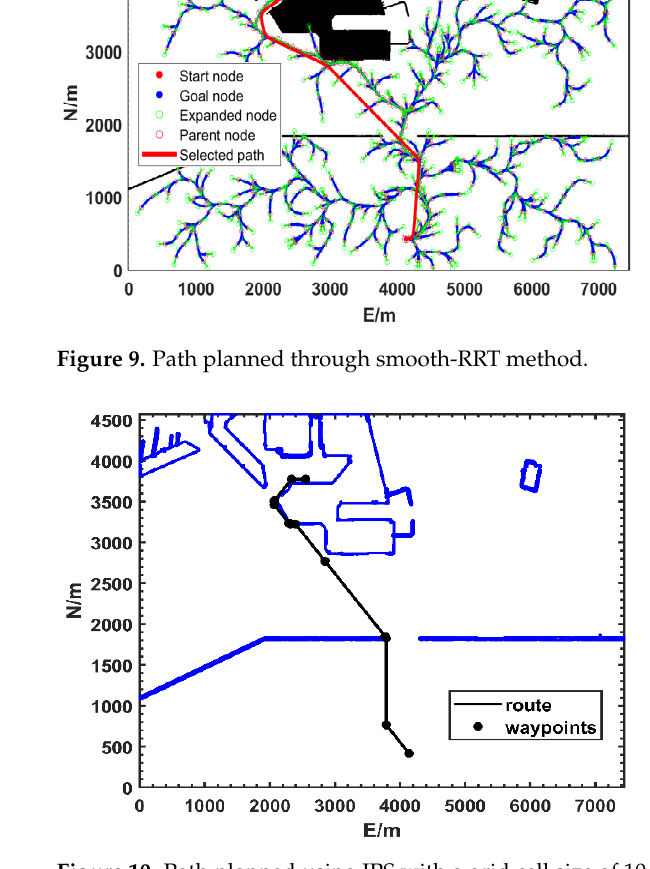
Figure 10. Path planned using JPS with a grid cell size of 10 m. Table 1. Comparison to common planning algorithms.